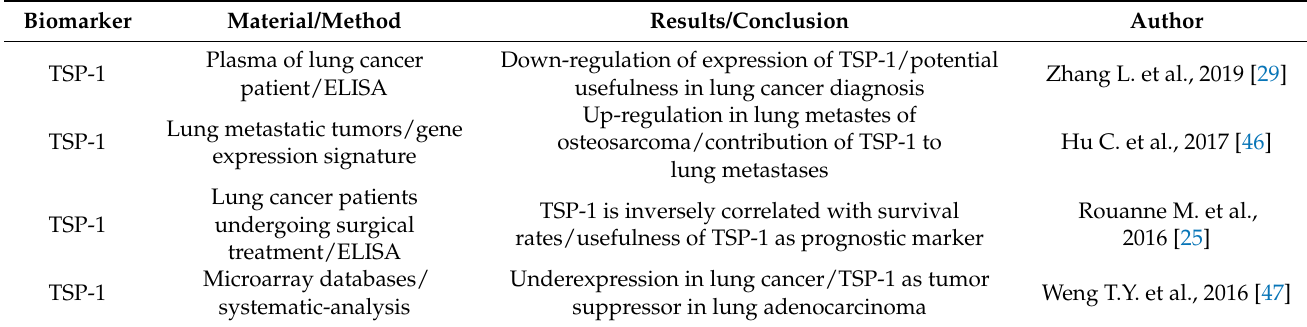
Table 5. TSP-1 and BMP-4 studies in lung cancer